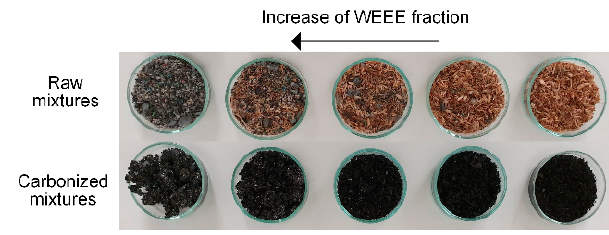
Figure 1. Biomass and carbonization